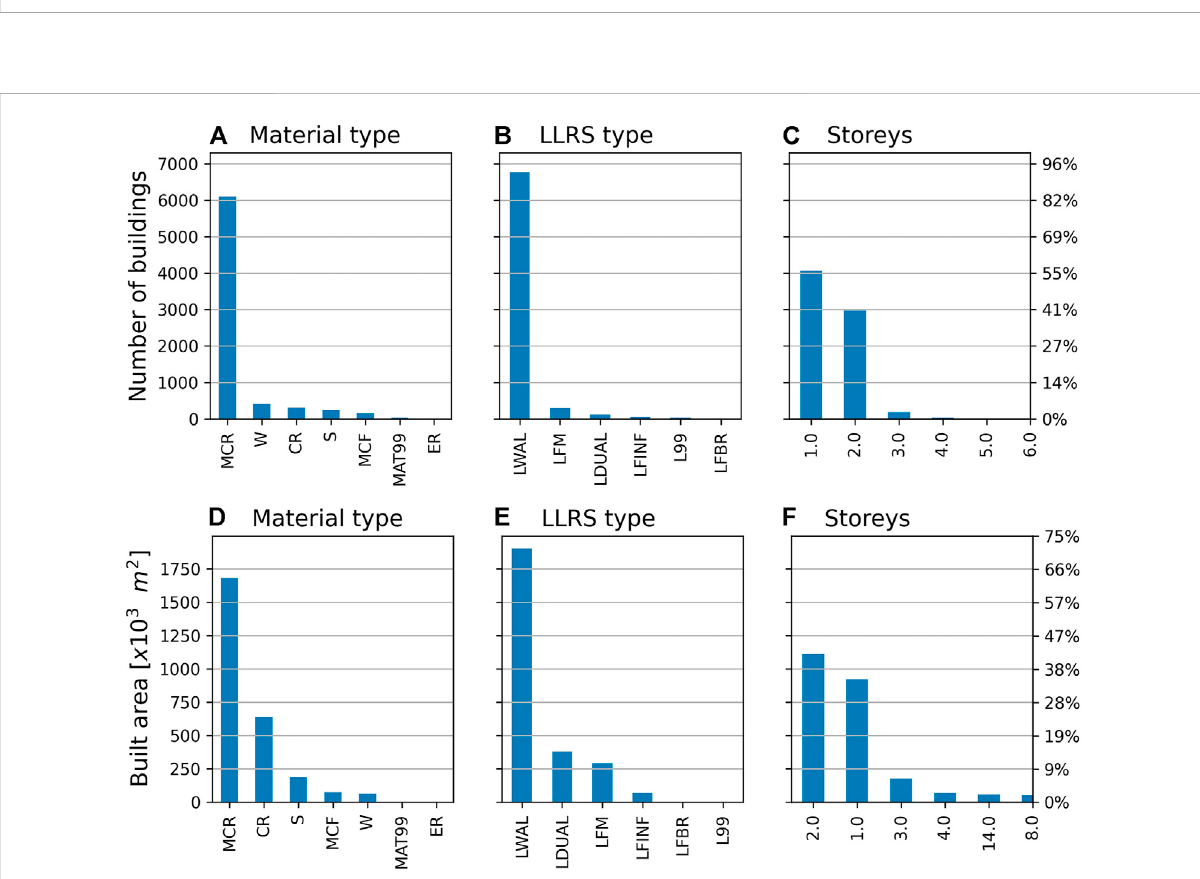
FIGURE 6 Material type,LLRStype,andanumber ofstoreysdistributions.Thefrequencydistribution isshown ontheleftaxis, andtherelativefrequencyis ontherightaxis.CR,concrete,reinforced;ER,earth,reinforced;L99,unknownLLRS;LDUAL,dualframe-wallLLRS;LFBR,bracedframeLLRS;LFINF, in fi lled frame LLRS; LFM, moment frame LLRS; LLRS, lateral load resisting system; LWAL, wall LLRS; MAT99, unknown material; MCF, masonry, con fi ned; MCR, masonry, con fi ned and reinforced; S, steel; W,